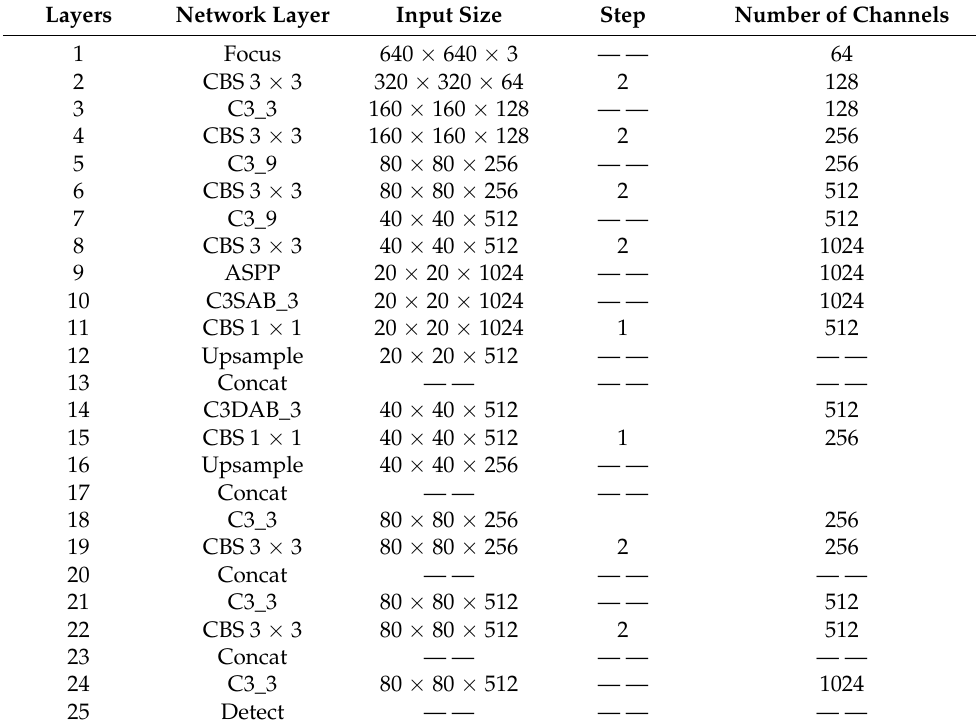
Table 2. Network